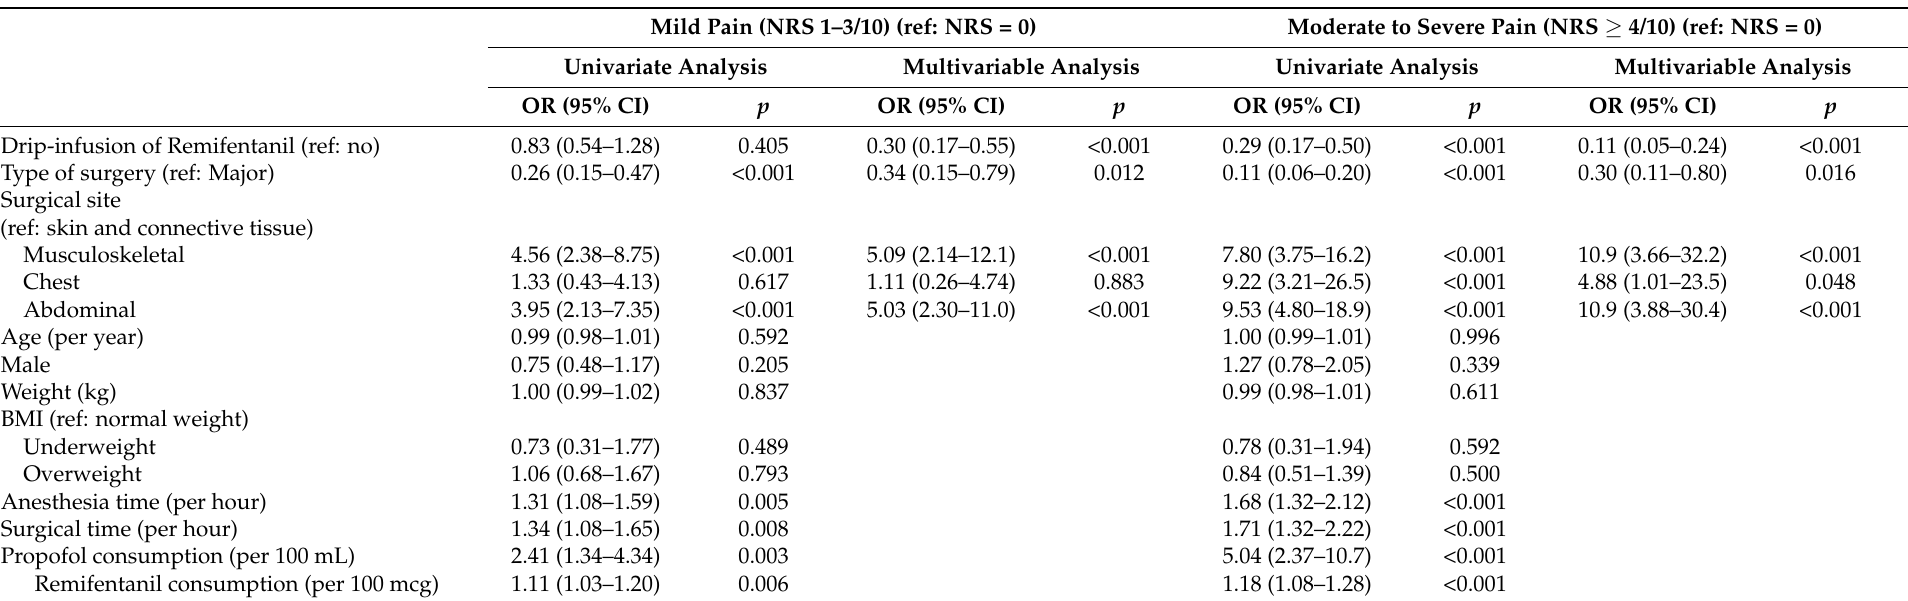
Table 2. Logistic regression analysis demonstrating factors associated with low or high NRS (ref: NRS =